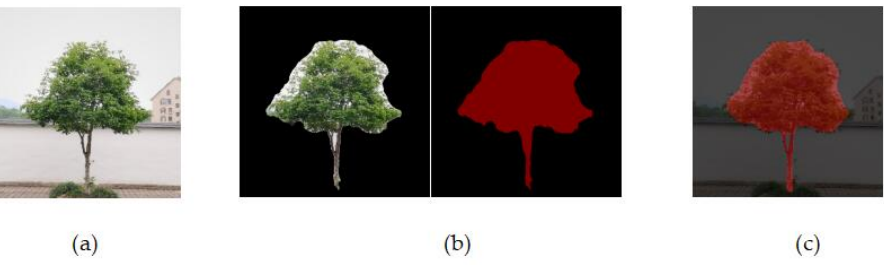
Figure 8. Overlay of segmentation results. ( a ) Original image. ( b ) Segmentation process. ( c ) Mask overlay.